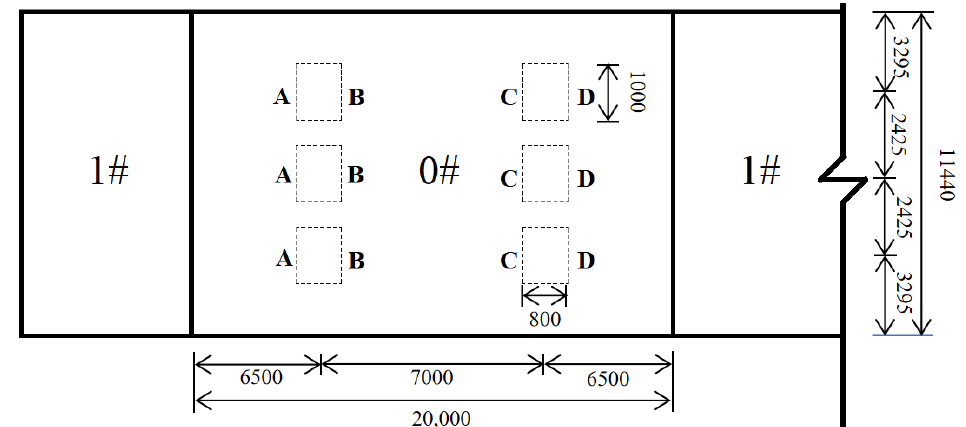
Figure 14. Schematic diagram of the compressive column (mm).